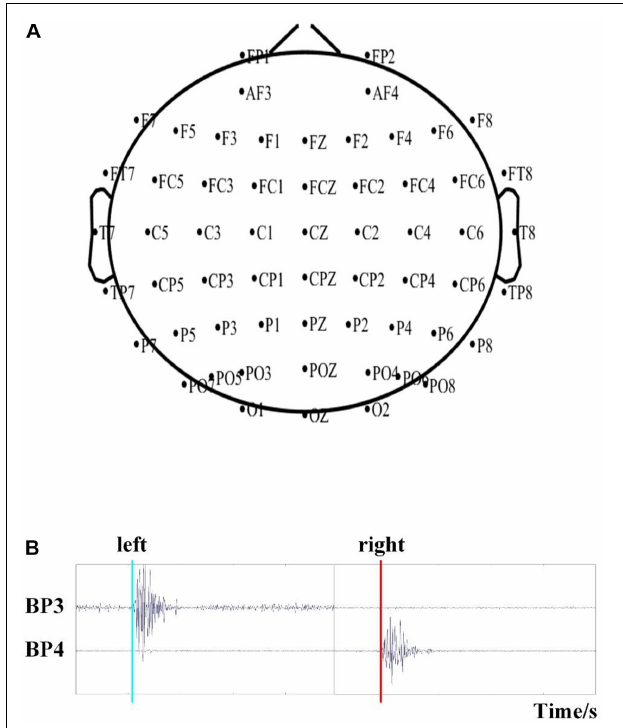
FIGURE 2 | (A) The position of the selected 59 EEG electrodes. (B) Detection of the time of movement onset based on EMG recordings.